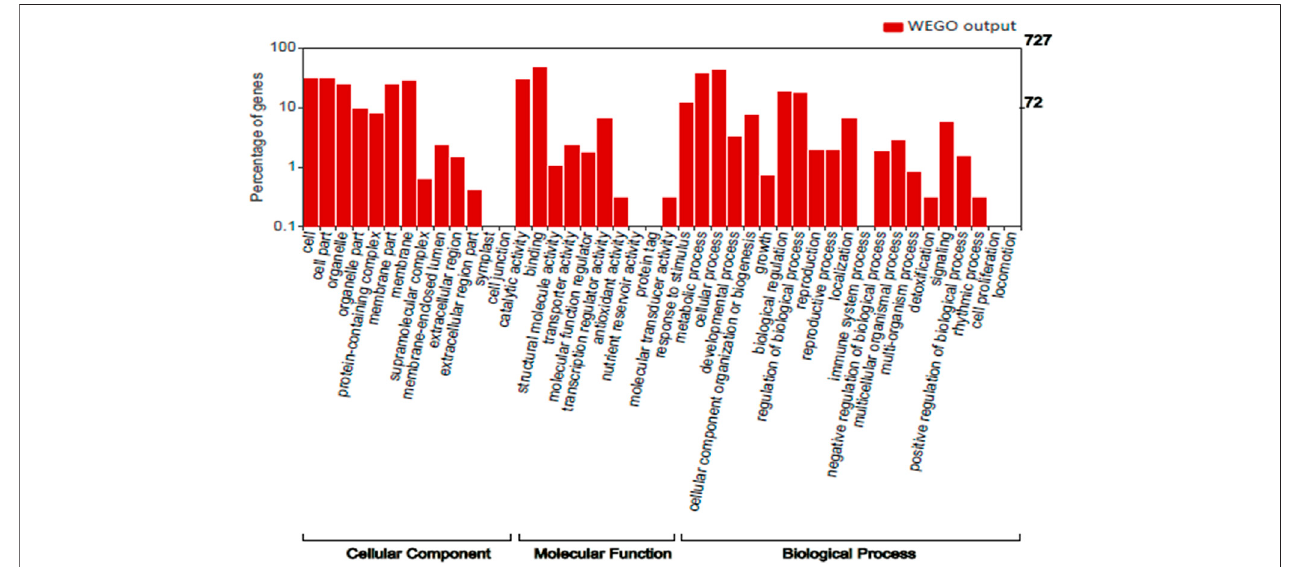
FIGURE 3 | Distribution of GO terms in the Cellular component, Molecular function and Biological process